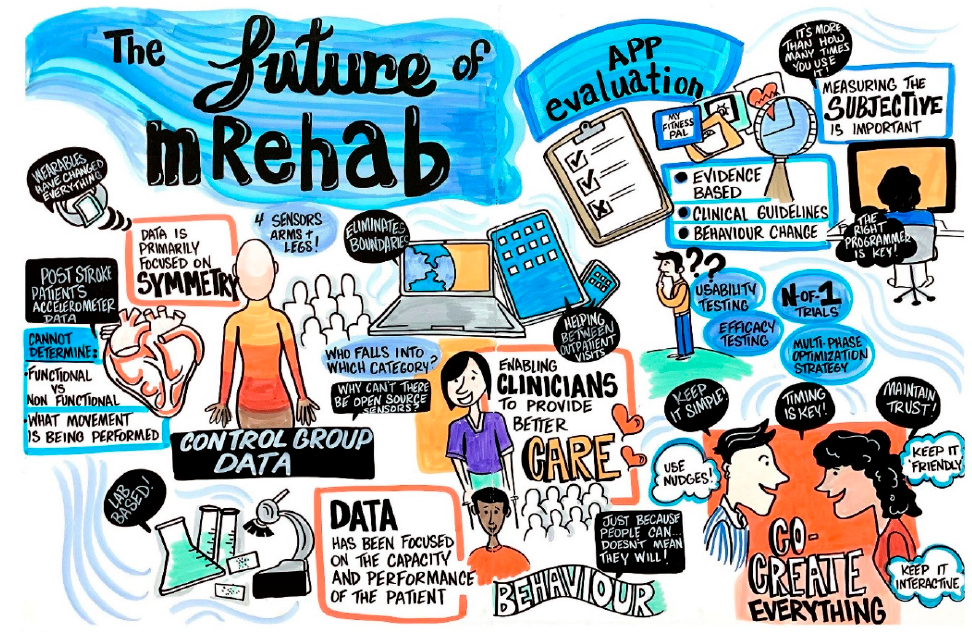
Figure 2. Graphical recording from the session on The Future of mRehab for People with Disabilities.